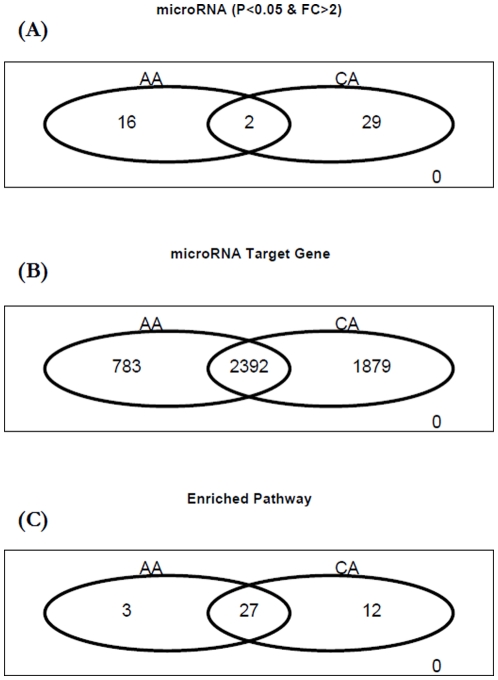
Venn diagrams showing the overlap at microRNA, target gene and pathway levels, respectively.
A) The differentially expressed microRNAs (P<0.05 & FC >2). B) The target genes predicted to be regulated by differentially expressed microRNAs. C) The enriched pathways (P<0.01) in target genes predicted to be regulated by differentially expressed microRNAs.